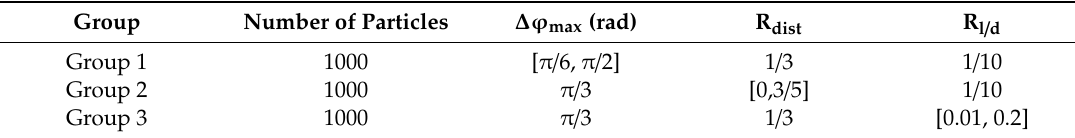
Table 1. Ranges of input